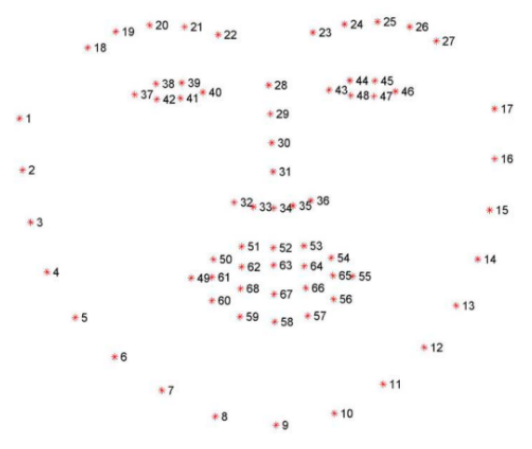
Figure 2. Facial landmarks included in the 300-W dataset .